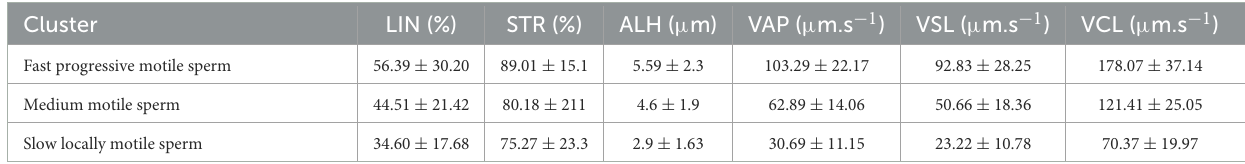
TABLE 1 Characterization of different sperm subpopulations determined by cluster analysis of kinematic parameters of motile spermatozoa. Cluster Fast progressive motile sperm Medium motile